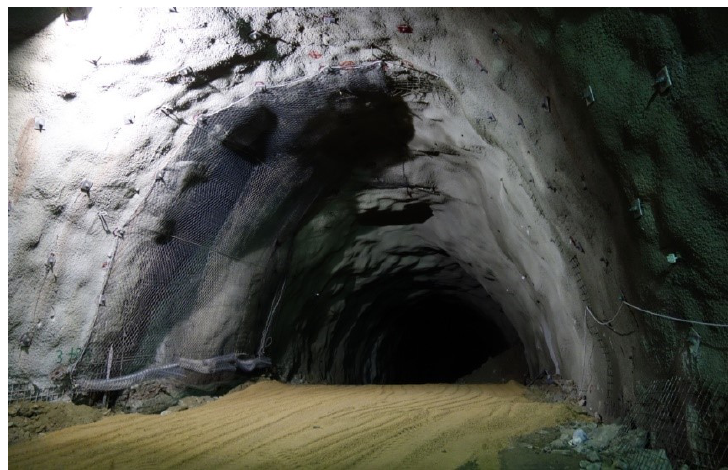
Figure 4. The collapse 2 mouth protection by the high-tensile steel mesh.